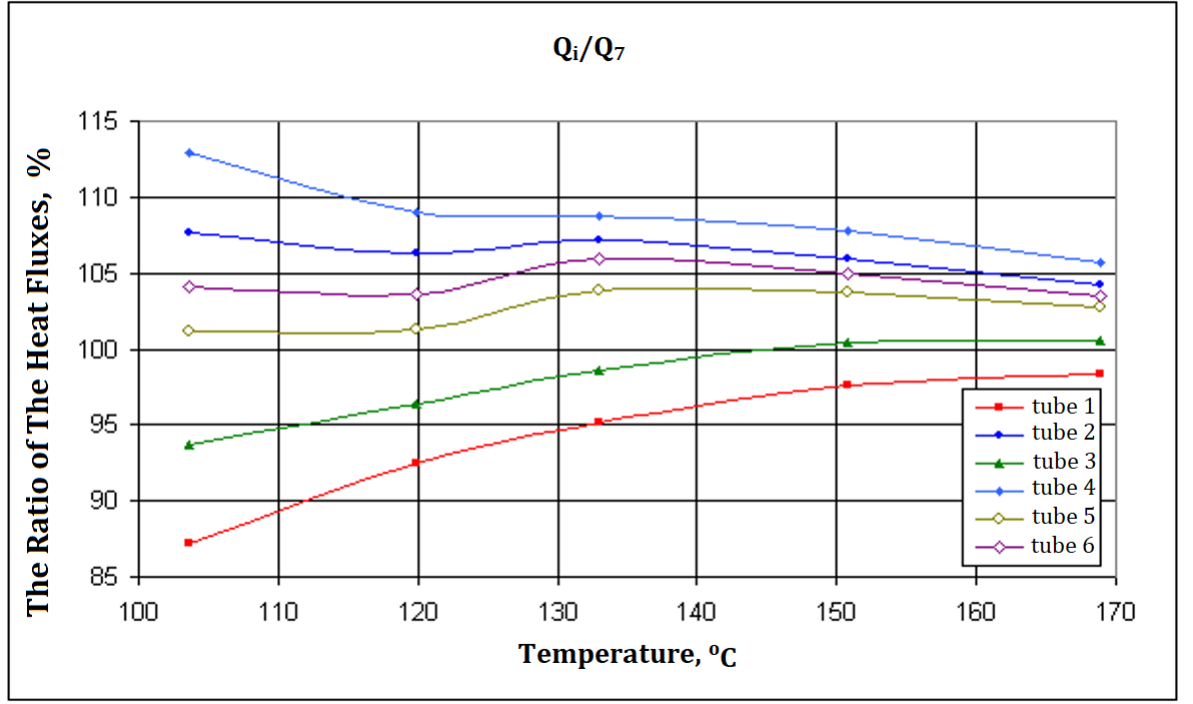
Figure 8. The ratio of the heat flux passing through the tested tubes to air (Qi) to the heat flux passing through (Q 7 ) the MAG-welded tube with a filler weld.